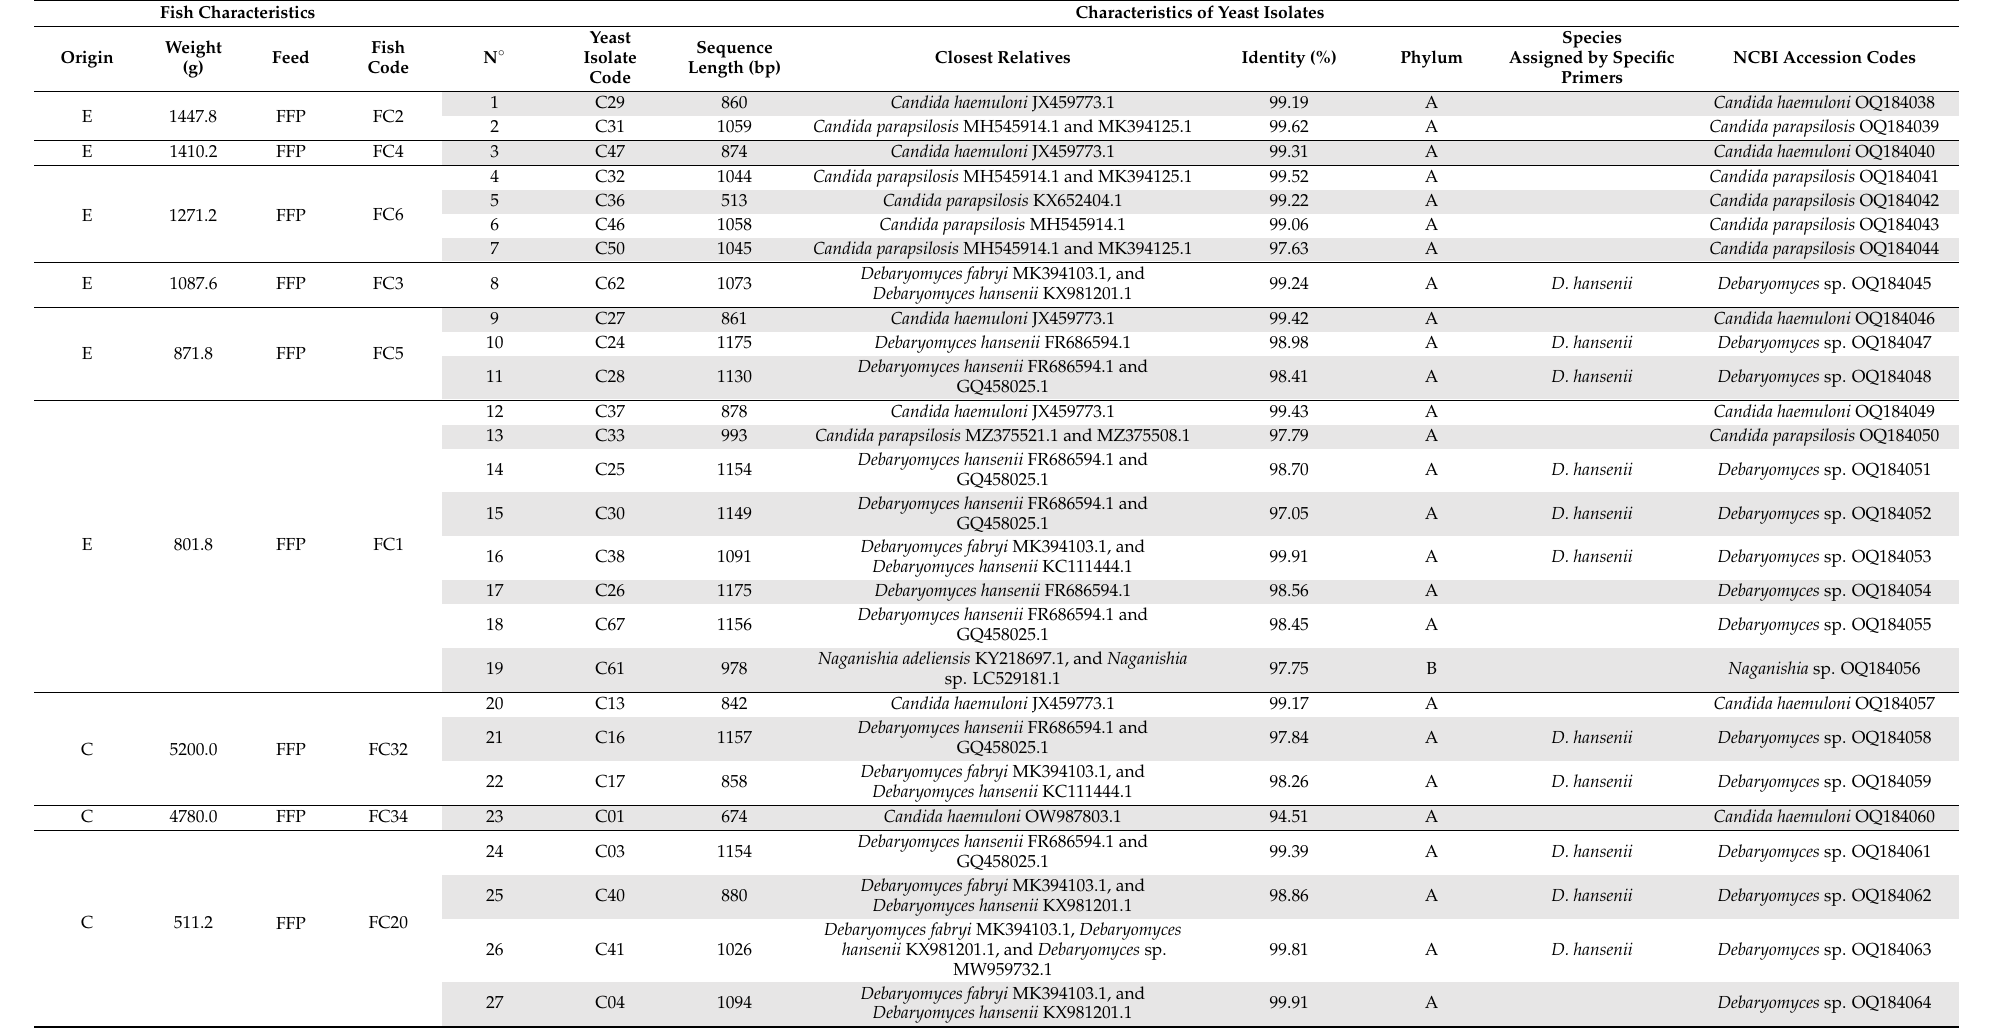
Table 1. Identification of yeast isolates cultured from the intestinal mucosa of cobia ( R. canadum